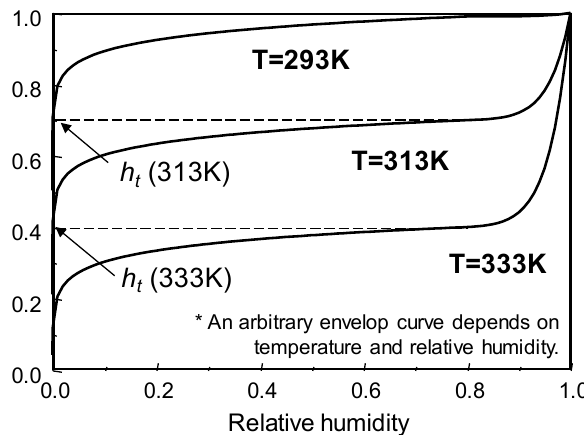
Figure 15. Enhanced moisture isotherm model of interlayer water under different temperature conditions [1,24].